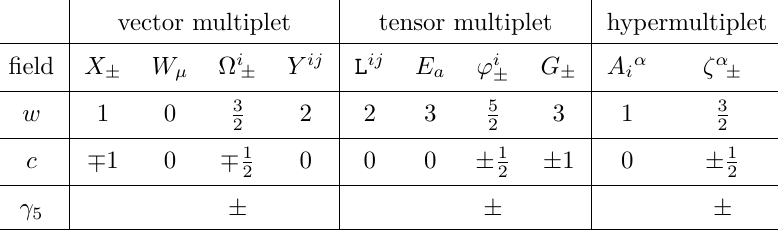
Table 4 . Weyl weights w , chiral SO(1 , 1) weights c , and chirality γ 5 for the fields in the Euclidean vector multiplet, tensor multiplet, and